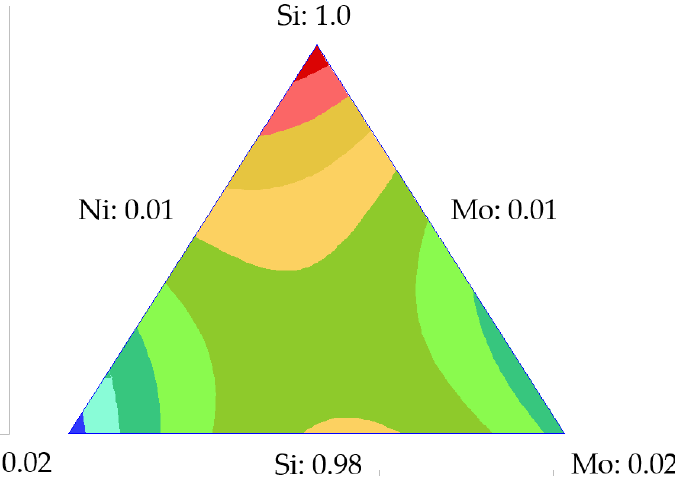
Figure 13. Response surface of adsorption for the Si-Ni-Mo mixture at 100 mg·L −1 and 25 ℃ .